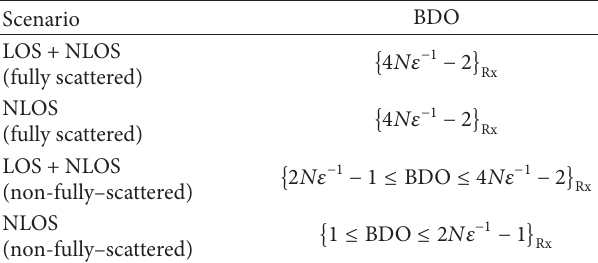
Table 1: BDO values depending on scenarios.